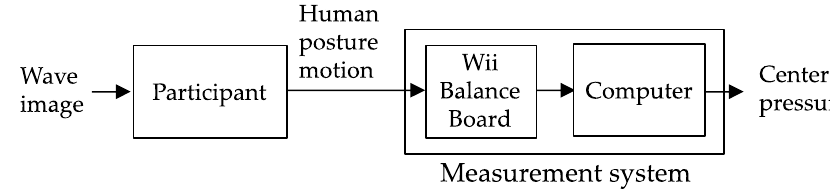
Figure 1. Schematic of the study.